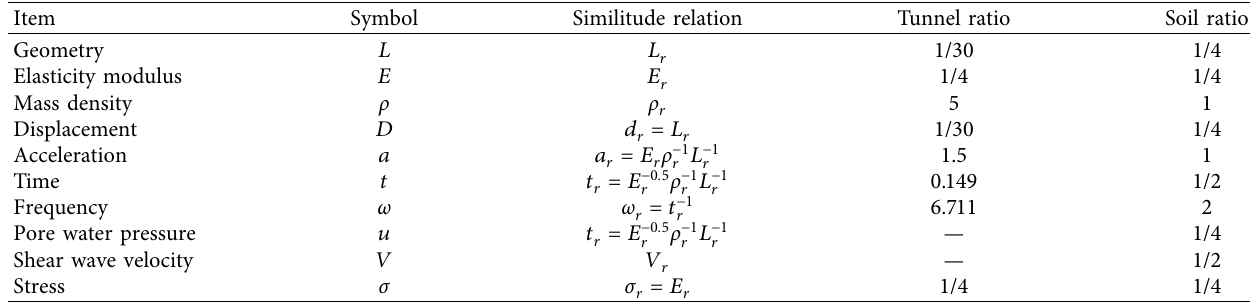
Table 2: Similitude relations and ratios of the model system.